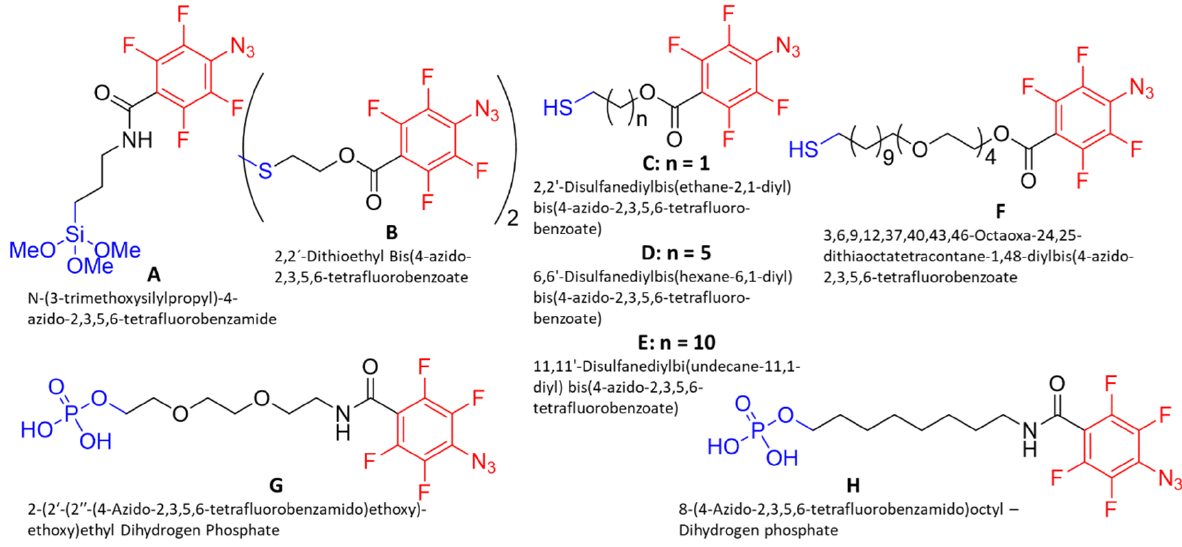
Figure 16. Perfluorophenyl azides (red) with anchor moieties (blue). Aryl azide chemistry has also been used to generate biocompatible surfaces based on carbohydrates. Carbohydrates received high attention because of their interactions with proteins and other biological entities. Therefore, Pei et al. synthesized a novel compound, carrying a PFPA as well as a disulfide moiety (Figure 16B), which was able to build a self-assembled monolayer on Au. This PFPA-derivatized surface was subsequently used to tether a thin layer of PEG upon thermal activation, because of the above-mentioned reasons. Carbohydrate-derivatized surfaces for selective protein binding were achieved, using different PFPA-derivatized carbohydrates, which coupled onto the surface upon UV irradiation via insertion reactions [192]. The scope of PFPA derivatized surfaces in biomed- ical applications was extended by the synthesis of four thiols (Figure 16C–F) with different chain lengths (spacer) containing hydrocarbon and ethylene oxide units between the thiol and the PFPA functionality. Gold nanoparticles were modified with these compounds followed by UV-coupling of different carbohydrates to study their interaction with proteins (binding affinity) depending on the size of the nanoparticle, spacer length, PFPA-density, etc. [193] The photochemical properties of PFPA were also employed to produce thin PEOX films on amino-functionalized glass slides by Pei et al. A monolayer of PFPA moieties was achieved by treating the aminosilylated glass slides with N-hydrox- ylsuccinimide-derivatized PFPA which was then irradiated with UV light after the PEOX film had been deposited. In the end, spatially addressable carbohydrate microarrays were produced through insertion reactions of PFPA derivatives in carbohydrates upon UV ir- radiation [194]. To modify (magnetic) iron oxide nanoparticles with carbohydrates for sen- sor applications, Yan and colleagues also synthesized two phosphate-functionalized PFPAs (Figure 16G,H), which can both react with superficial hydroxyl groups to form a stable Fe-O-P bond [195]. An efficient photocoupling agent, based on PFPA conjugated polyallylamine, was developed by Kuba et al. for the photo-induced immobilization of polymers (PS, PEOX, poly(vinyl pyrrolidone)), nanoparticles (PS fluorescent silica nanoparticles), graphene and small molecules (carbohydrates) on Si-wafers, which were pre-modified with epoxy groups at the surface via silanization with 3-glycidyloxypropyltrimethoxysilane. The pho- tocoupling agent was received through the reaction between amino groups of polyallyla- mine hydrochloride and N-hydroxylsuccinimide-derivatized PFPA. The remaining amino groups were then used to covalently couple the reagent to the Si-wafer surface via the reaction with epoxides. The authors claimed a higher immobilization efficiency com- pared to PFPA-silane functionalized surfaces [196].